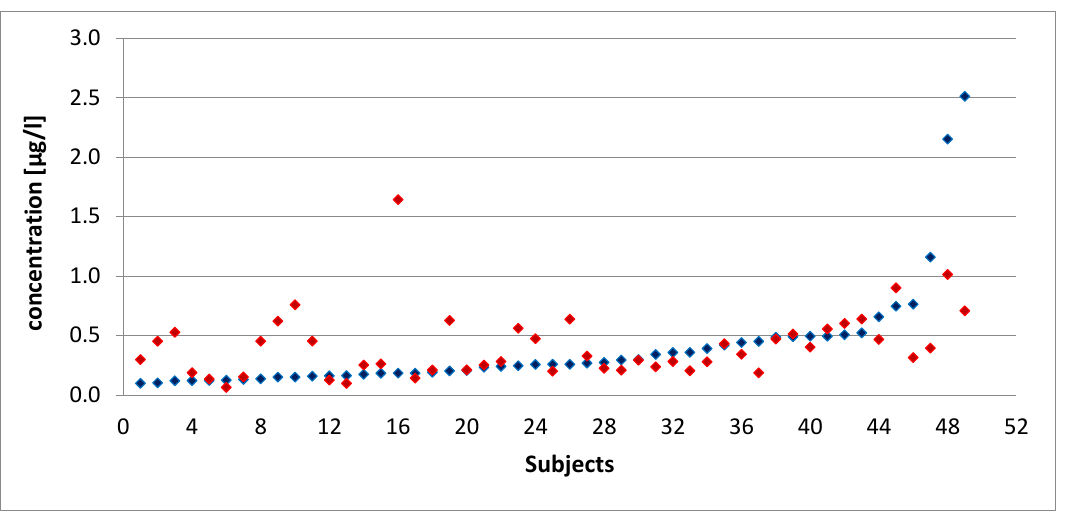
Figure 9. Comparison between Pb urinary concentrations (µg/L) estimated by MERLIN software (red dots) and measured concentrations (µg/L) reported in the HBM study (blue dots). Table 6. Comparison between concentrations estimated by MERLIN software (M) and measured concentrations reported in the Human Bio-monitoring study (HBM): average value (A.V.) and standard deviations (St. Dev.). Pb = Lead, Ant = Anthracene, Flt = Fluoranthene.